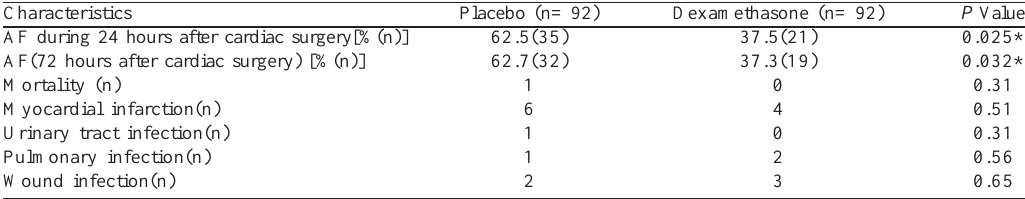
Table 3. Postoperative side effects of the Patient Groups Characteristics AF during 24 hours after cardiac surgery[%(n)] AF(72 hours after cardiac surgery) [%(n)] Mortality (n) Myocardial infarction(n) Urinary tract infection(n) Pulmonary infection(n) Wound infection(n) Numbers (n) and percentages (%). *Significant